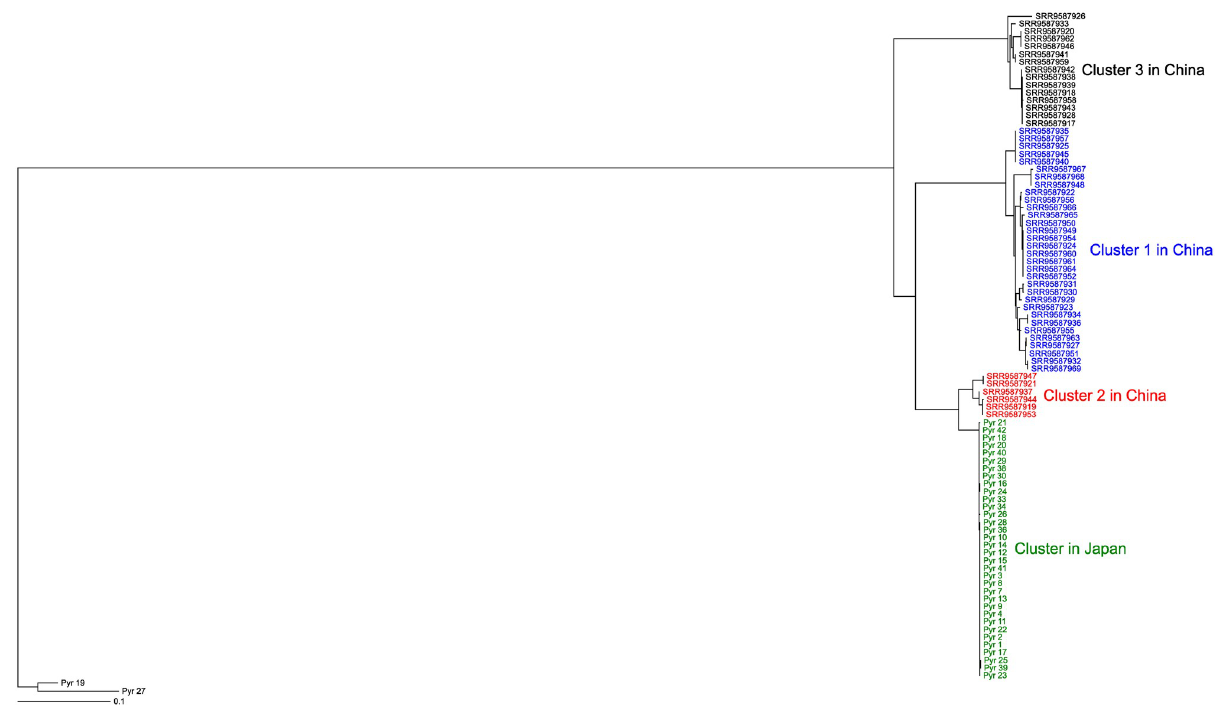
Fig 3. Phylogenetic tree of Pyropia yezoensis samples using the mitochondrial DNA sequences based on maximum likelihood reconstruction. The scale bar shows the number of substitutions per site. The sequences of Pyr_19 ( P . tenera ) and the hybrid (Pyr_27) between P . yezoensis and P . tener a were used as roots. Colors were used to distinguish between Japanese P . yezoensis and 3 clusters of Chinese P . yezoensis . The parameters for RAxML were as follows: -f = a, -x = 12,345, -p = 12,345, -N (bootstrap value) = 1,000, -c = 1, and -m = GTRCATX). Only variable sites were used in the analysis.